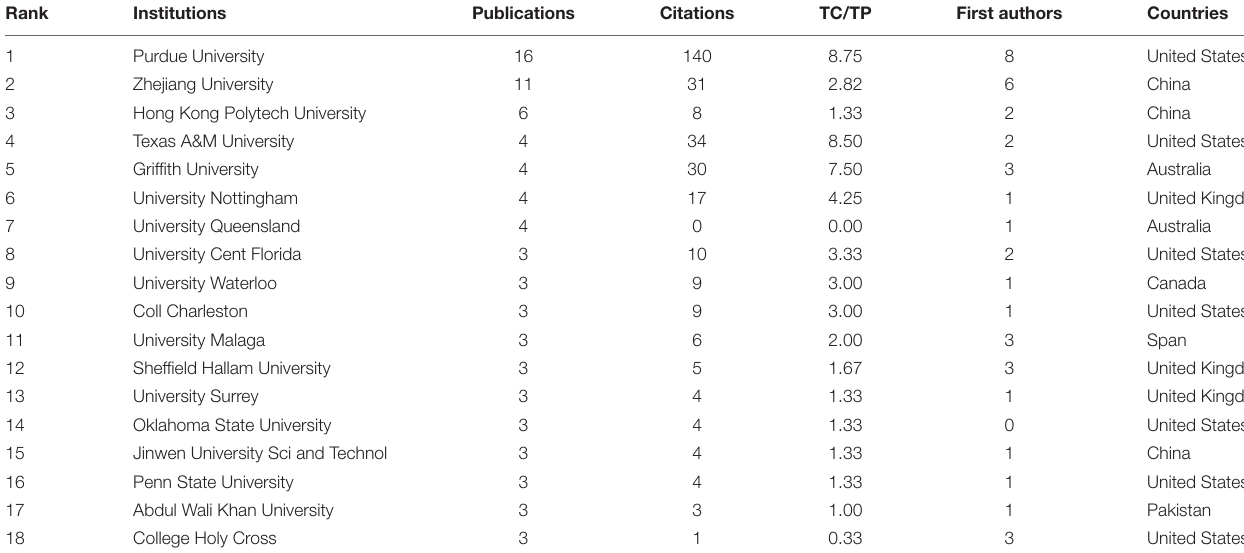
TABLE 3 | Top institutions in family tourism research.